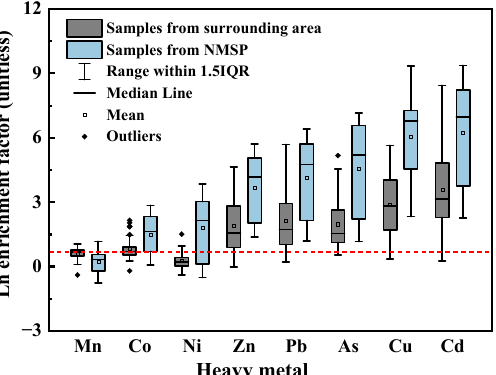
Figure 2. Box-plots of the natural logarithm of the enrichment factor (EF) values for heavy metals in soils of surrounding area and non-ferrous metal smelting plant (NMSP).